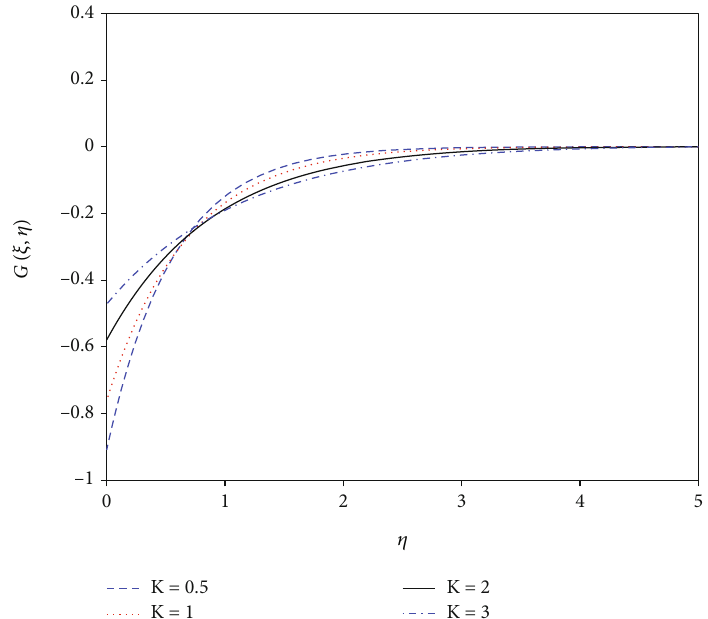
Figure 3: Microrotation pro fi le G ð ξ , η Þ for di ff erent values of vortex viscosity parameter K , when n = 0 : 5, ξ = 5, Pr = 10, S = 1, Ω = 0 : 1, N , and He = 0 : 2 :